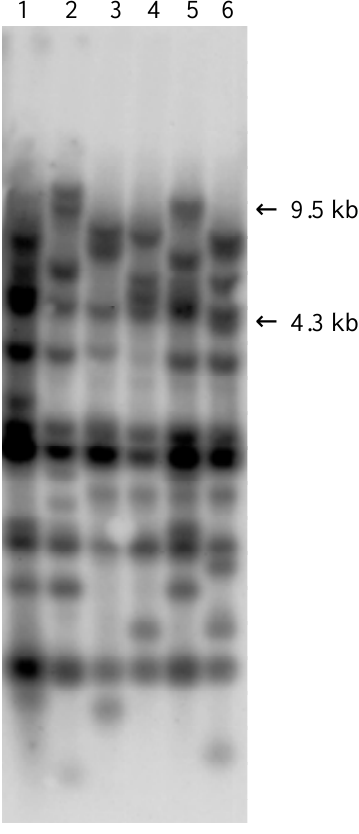
Figure 1 - Soybean genomic DNA hybridization analysis with RFLP probe A45-10. Lanes are as follows: Hin dIII digest of soybean genomic DNA from genotypes: 1, Bonus; 2, PI 81762; 3, PI 416937; 4, N85-2176; 5, PI 153293; 6, PI